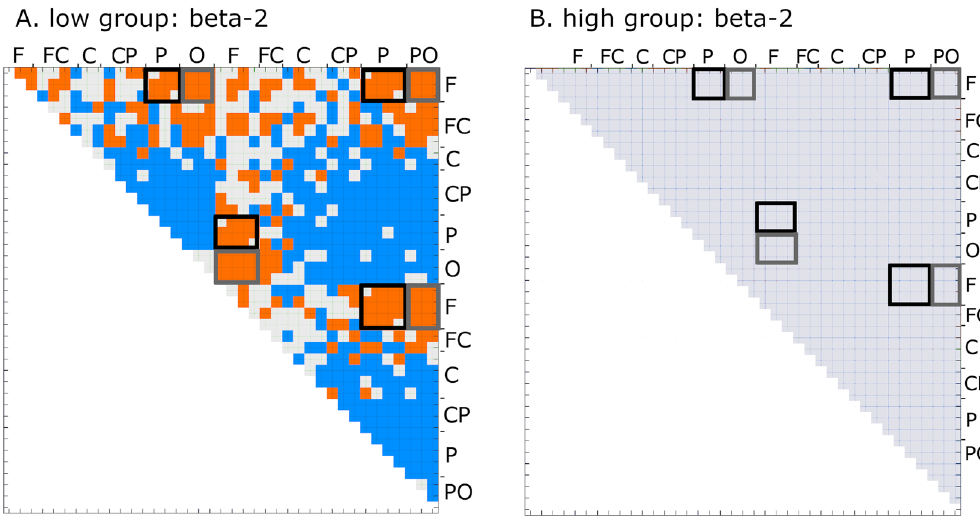
Figure 5. Significant (p < 0.05, FDR corrected) differences of the PLVs in the beta-2 band between retest and test sessions for the low-gB2rest group ( A ) and lack of significant differences for the high-gB2rest group ( B ) in the visual search task. Red and blue depict significant positive and negative differences, respectively, between retest and test; black outlines denote frontoparietal connections; gray outlines denote frontooccipital